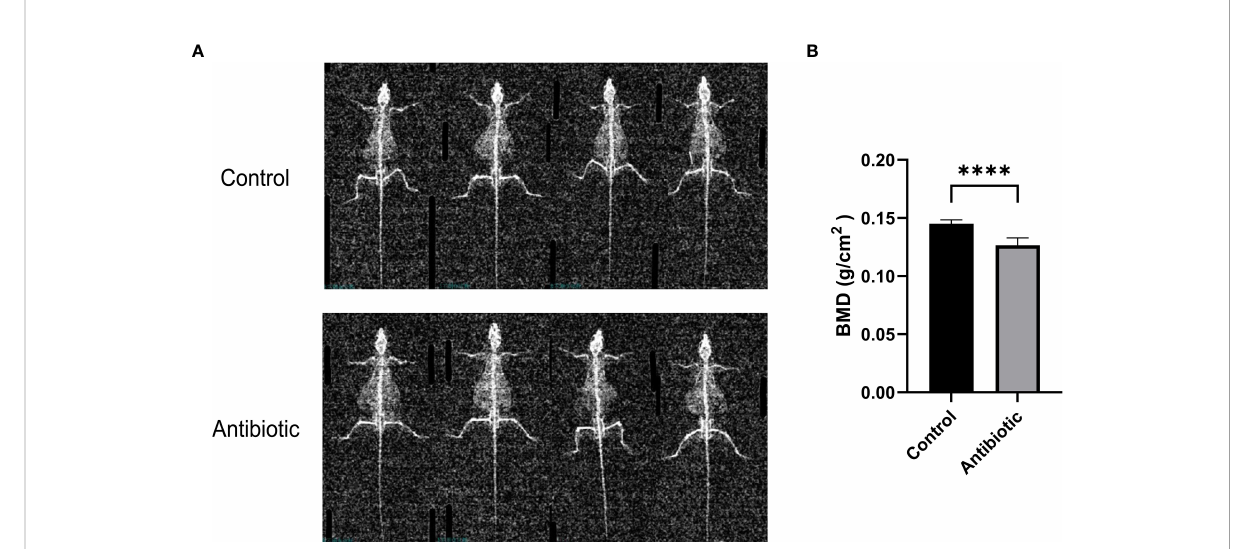
FIGURE 3 Dual-energy X-ray images and quanti fi cation of bone mineral density were analyzed (A) dual-energy X-ray images of the control and antibiotic groups; (B) comparison of bone mineral density between the two groups (P<0.0001). Data points are expressed as mean ± SD, and a t-test was used for comparison between groups. ****p<0.0001.